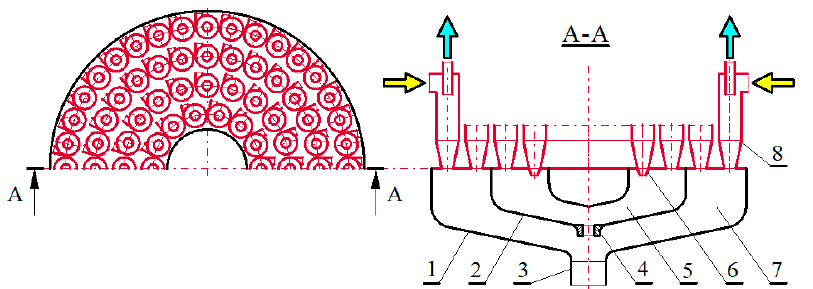
Figure 10. Suction system concept according to the combined method: 1—settling tank bottom, 2—partition, 3—suction port, 4—flange, 5—external channel, 6—internal channel, 7—choke cap, 8—cyclone.